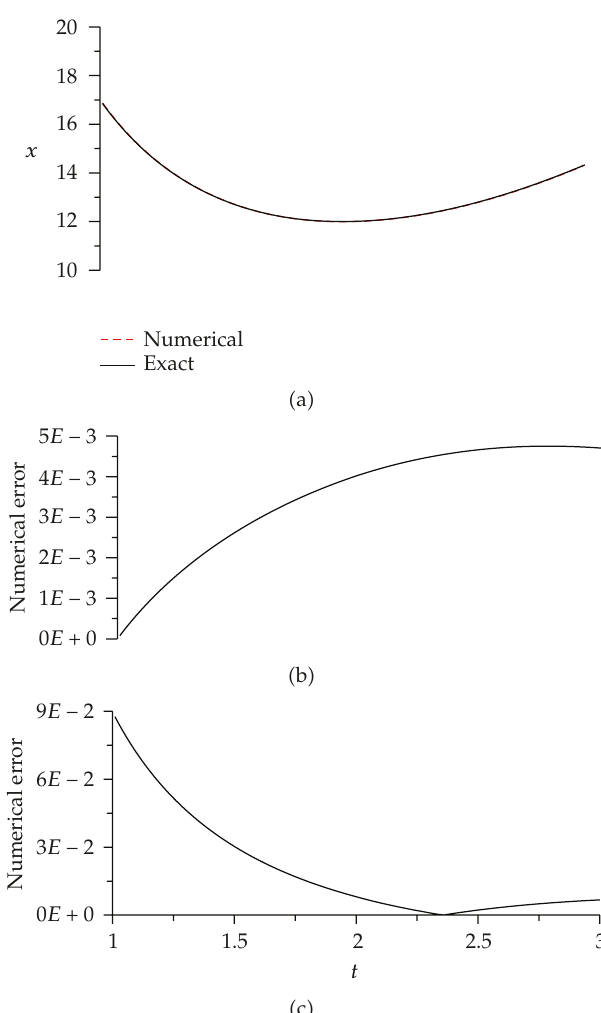
Figure 5: For example 4: (cid:3) a (cid:4) comparing numerical and exact solutions, (cid:3) b (cid:4) and (cid:3) c (cid:4) displaying the errors for two di ff erent boundary